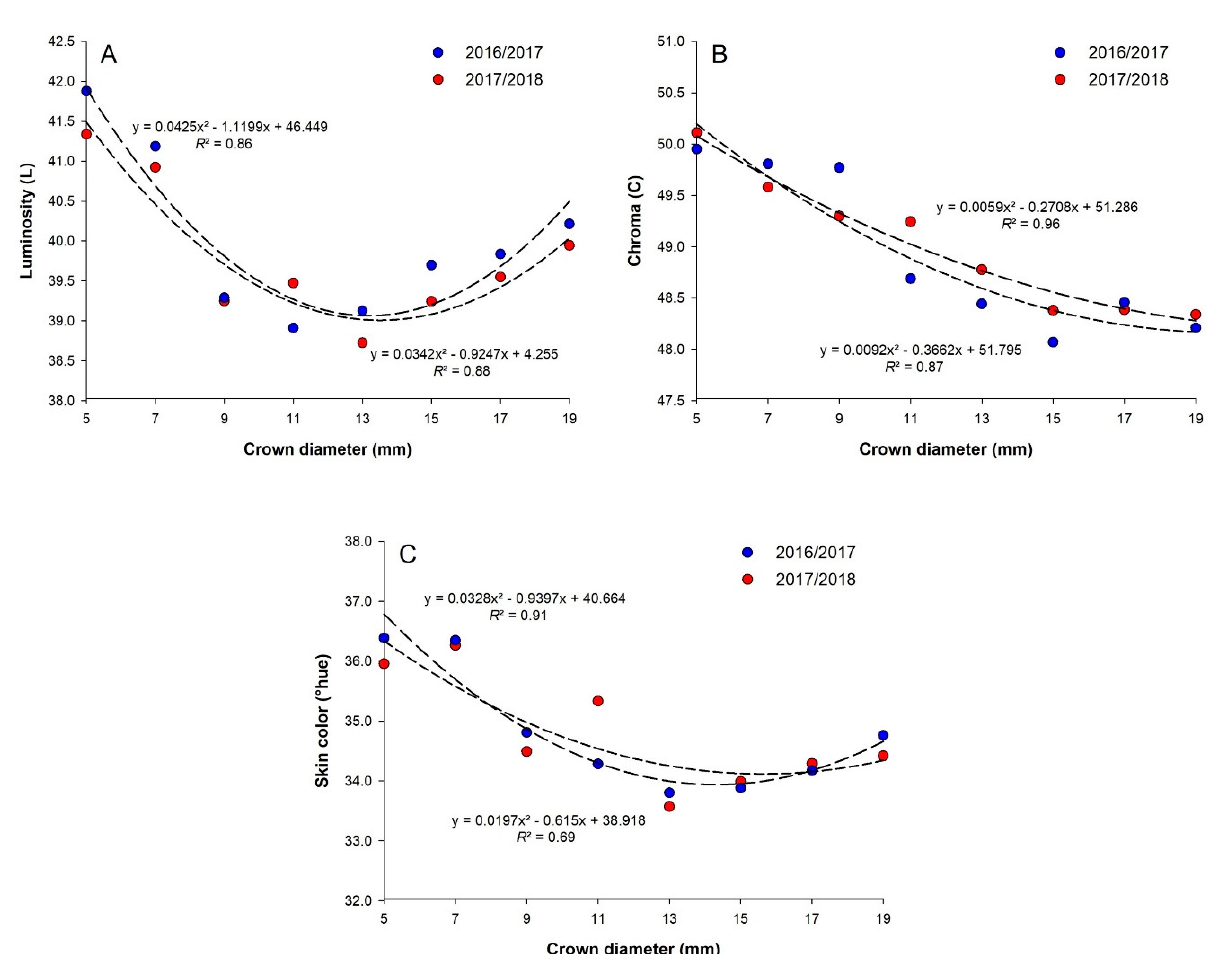
Figure 6. The response of the parameters related to the fruit’s epidermis coloration, represented by the values of luminosity ( A ), chroma ( B ), and the skin color (°hue) ( C ) in strawberry plants cv. ‘Pircinque’, depending on different plant crown diameters (5, 7, 9, 11, 13, 15, 17, and 19 mm) in the 2016/2017 and 2017/2018 production cycles.